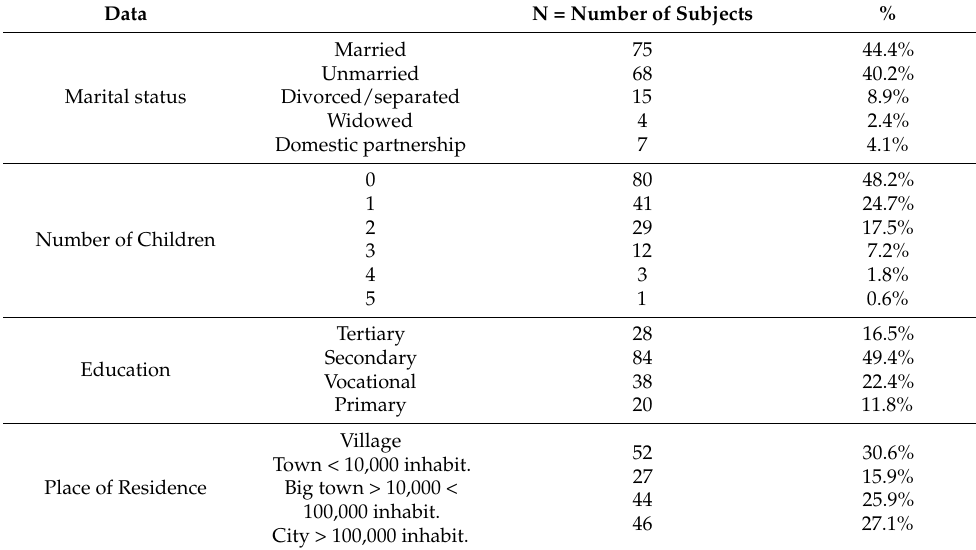
Table 1. Sociodemographic